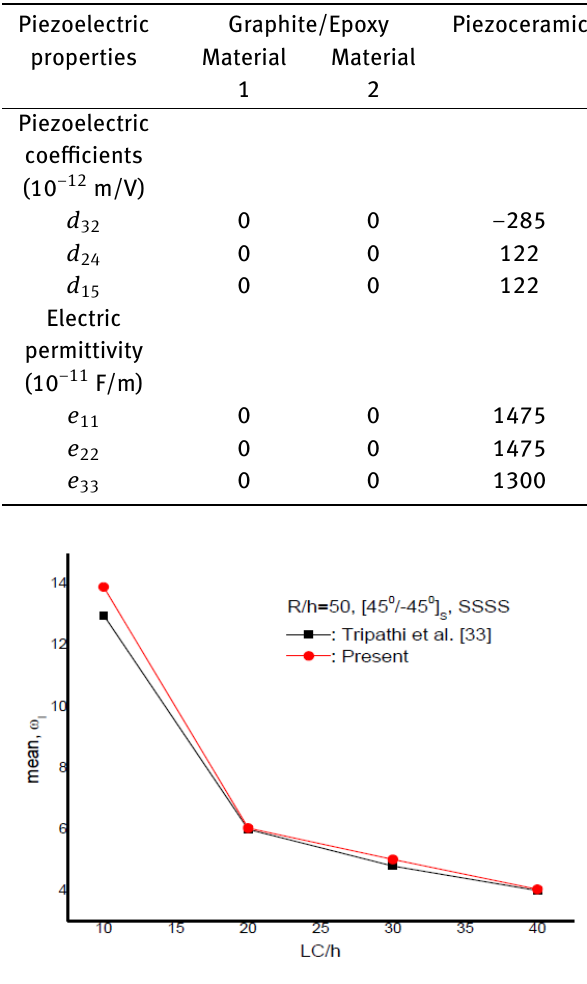
Figure 3: Validation study of mean fundamental frequency in 1000 rad/s for a laminated [-45 ∘ /45 ∘ ] s simply supported cylindrical panel, with R/h=50, for the discrete value of LC/h Table 3: Validation study of fundamental frequency for simply